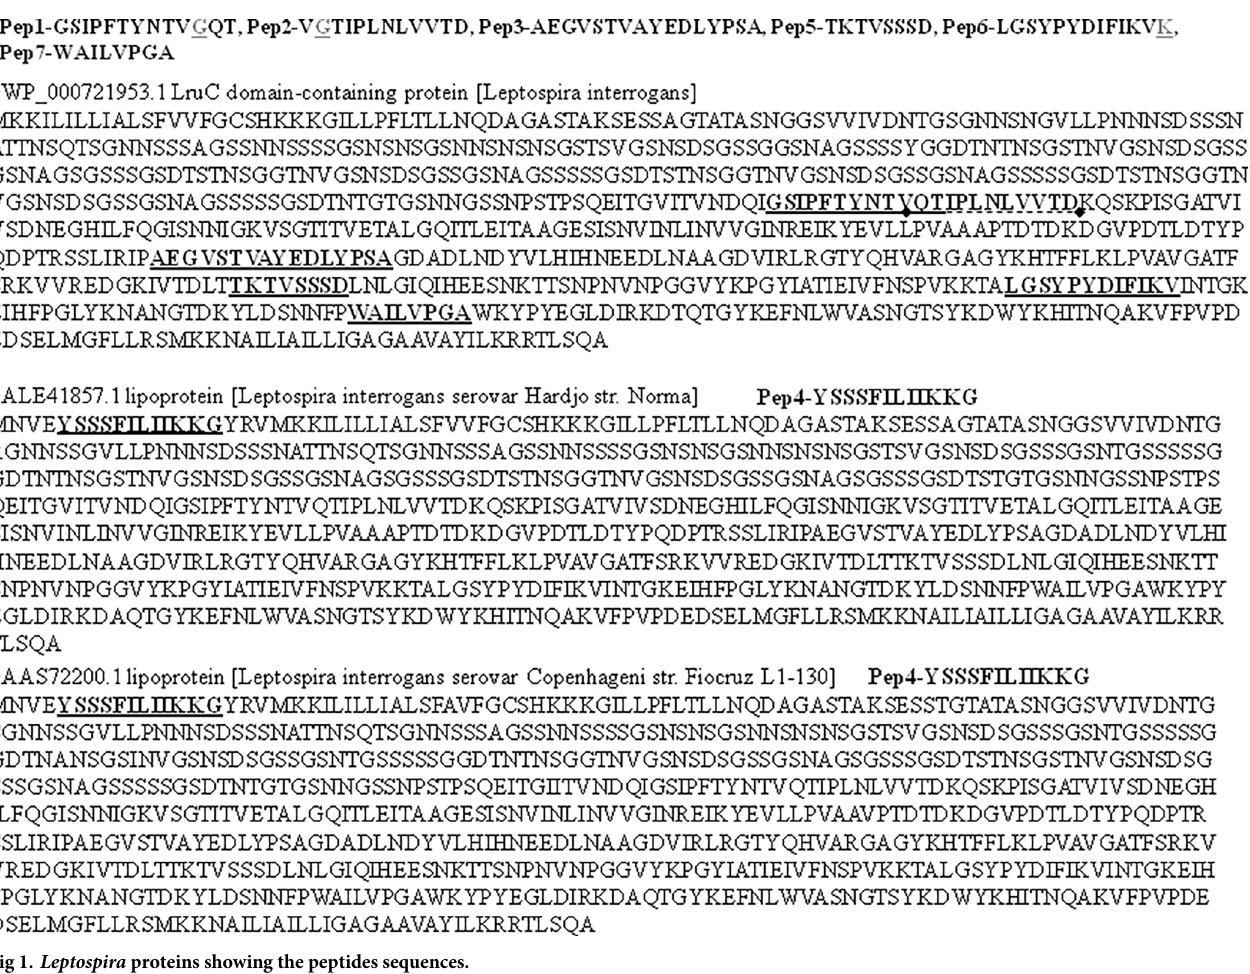
PLOS ONE | https://doi.org/10.1371/journal.pone.0281344 February 6,